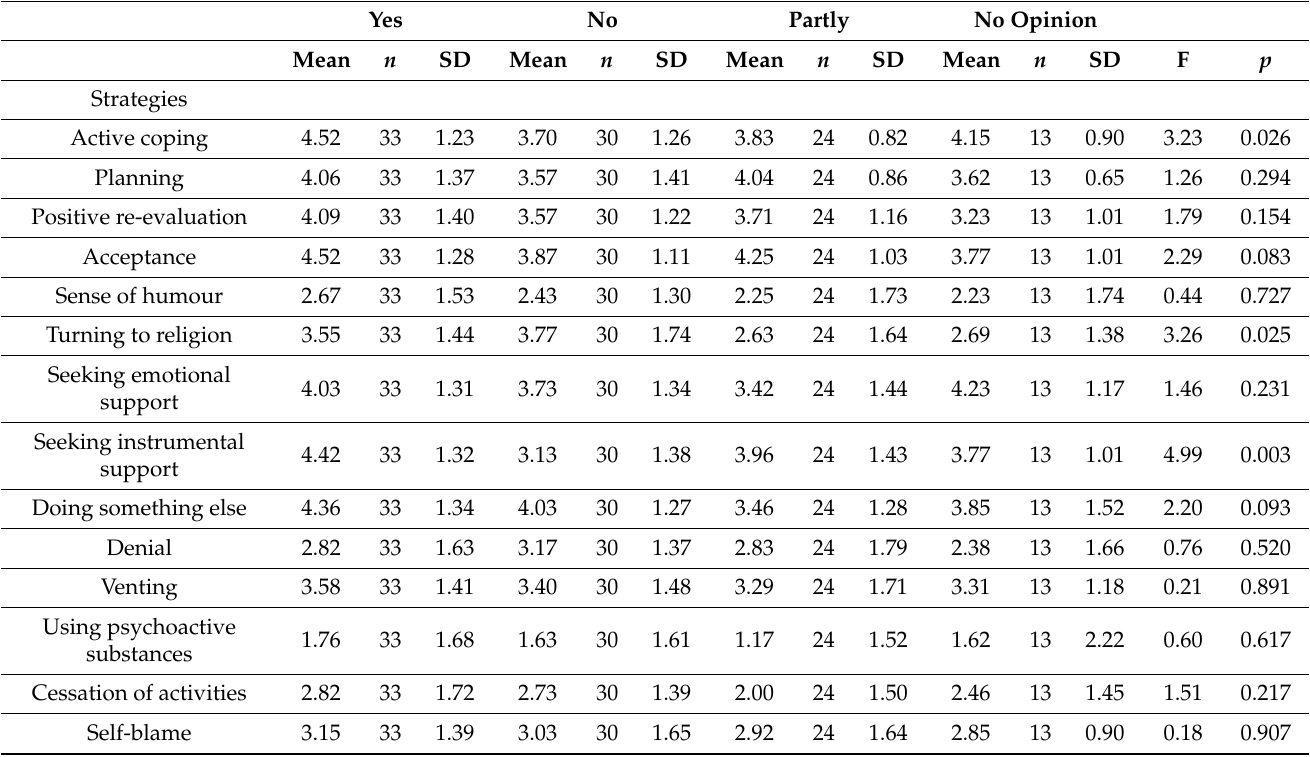
Table 4. The influence of the COVID-19 pandemic on coping with stress by the respondents and strategies of coping with